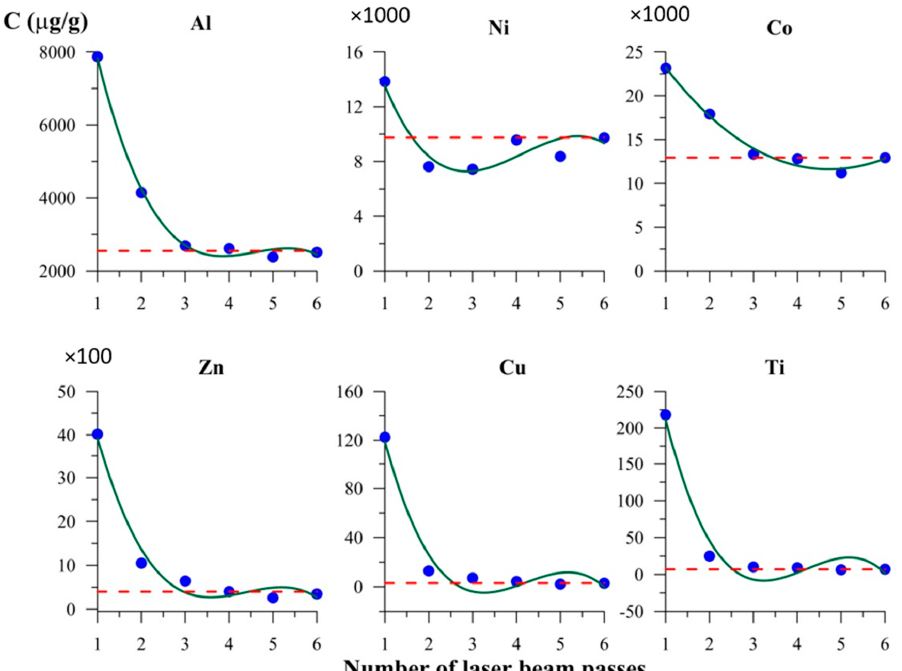
Figure 6. Elements content in the course of layer-by-layer laser ablation inductively coupled plasma mass spectrometry (LA-ICP-MS) analysis of crystal surface. Magnetite crystal from Experiment 1 (Tables 1 and A1). The first two laser passes distinctly detect higher contents of TE with respect to the volume concentration (dotted line), although the uncertainty is relatively high for TEs in two most surficial lines (at a level of ± 30% rel.).